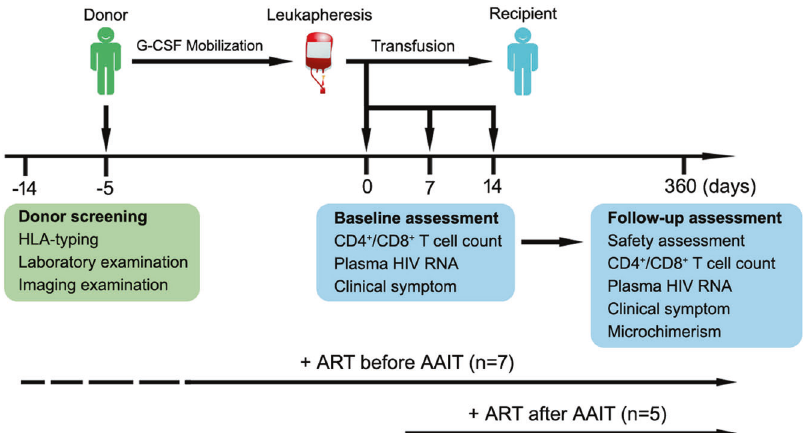
Fig. 1 Structure of the phase I, single-arm, AAIT study. AAIT was performed in 12 severely immunosuppressed AIDS patients. Seven patients received AAIT after ART, and fi ve received AAIT before ART. Anti-OI treatments were given as necessary during the immunotherapy. G-CSF granulocyte-colony-stimulating factor, AAIT allogeneic adoptive immune therapy, OIs opportunistic infections, ART antiretroviral